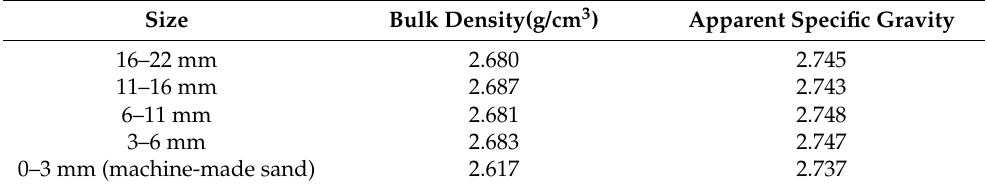
Table 2. The density of the aggregates.